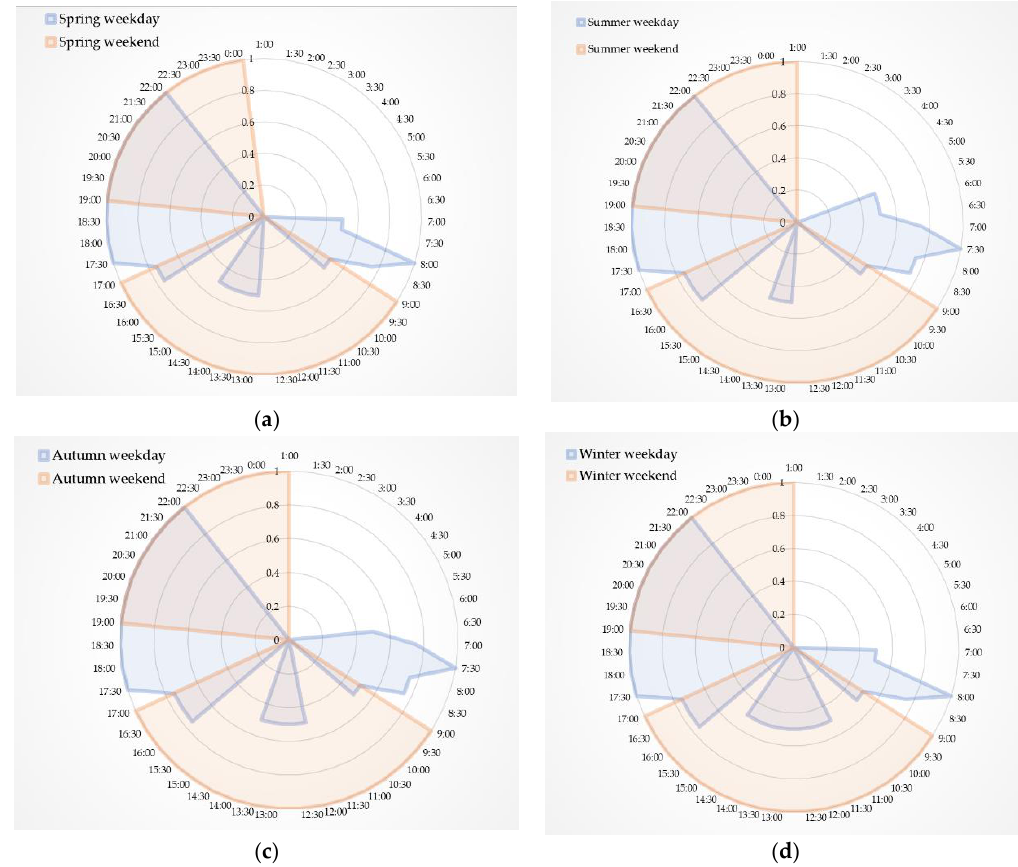
Figure 7. The household consumption on four seasonal days. ( a ) Spring; ( b ) Summer; ( c ) Autumn; ( d ) Winter.